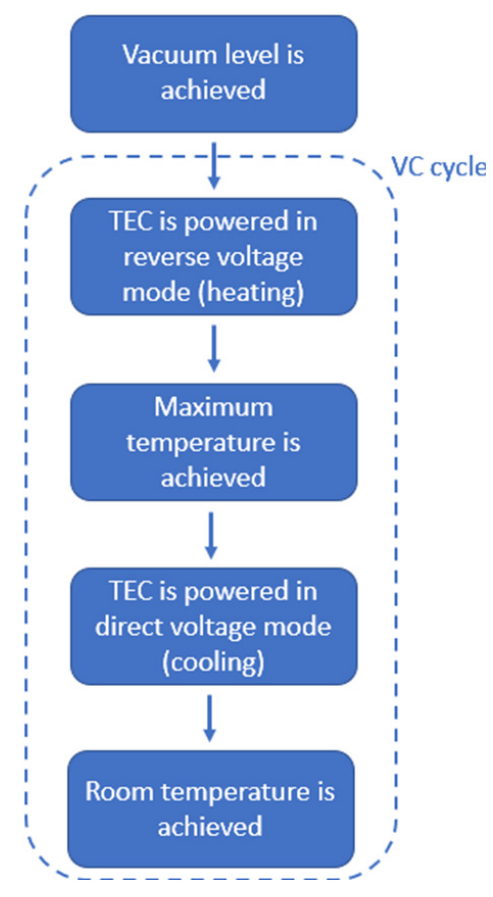
Figure 3. Flowchart of the calibration procedure.